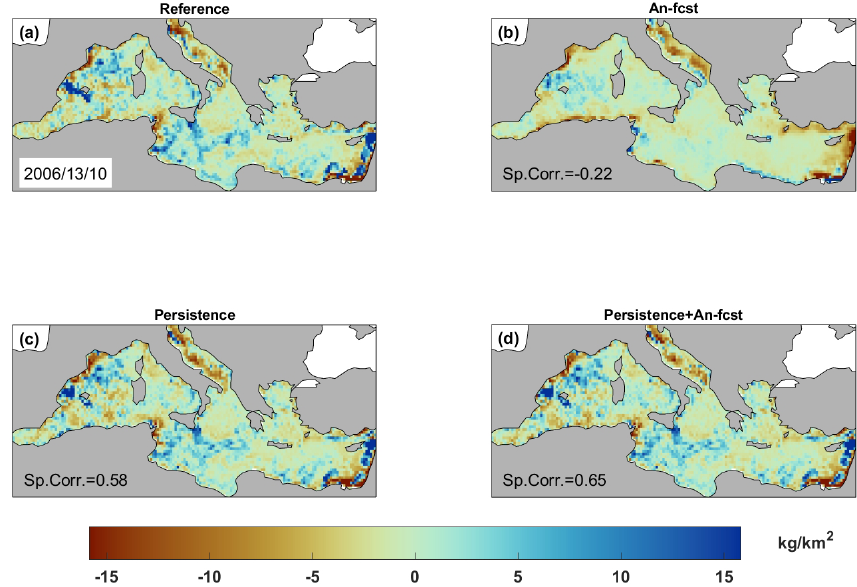
Figure 8. Same as Fig. 7 but for a situation where the forecasts perform worse.